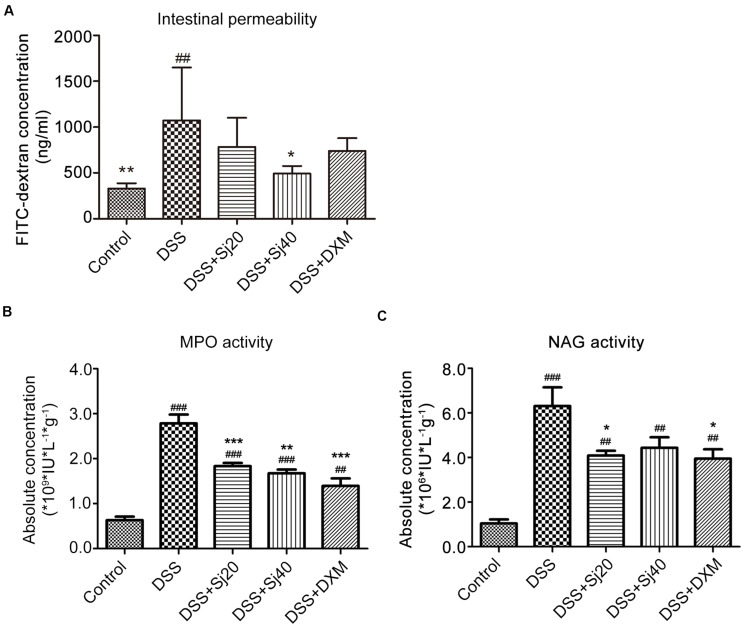
The impairment of the intestinal permeability induced by IBD is decreased after treatment with mSjci. (A) The FITC-dextran concentration (reflecting intestinal permeability) was calculated according to a standard curve. The data (means ± SDs; n = 5) were analyzed by one-way ANOVA. (B) The mice were treated as indicated, and 7 days later, the myeloperoxidase (MPO) and (C)
N-acetylglucosaminidase (NAG) activities in colon tissue were determined by ELISA. The bars represent the means ± SD (n = 5). The significant differences among the groups were analyzed by one-way ANOVA. ##p < 0.01, ###p < 0.001 compared with the control group; *p < 0.05, **p < 0.01, ***p < 0.001 compared with the DSS group.